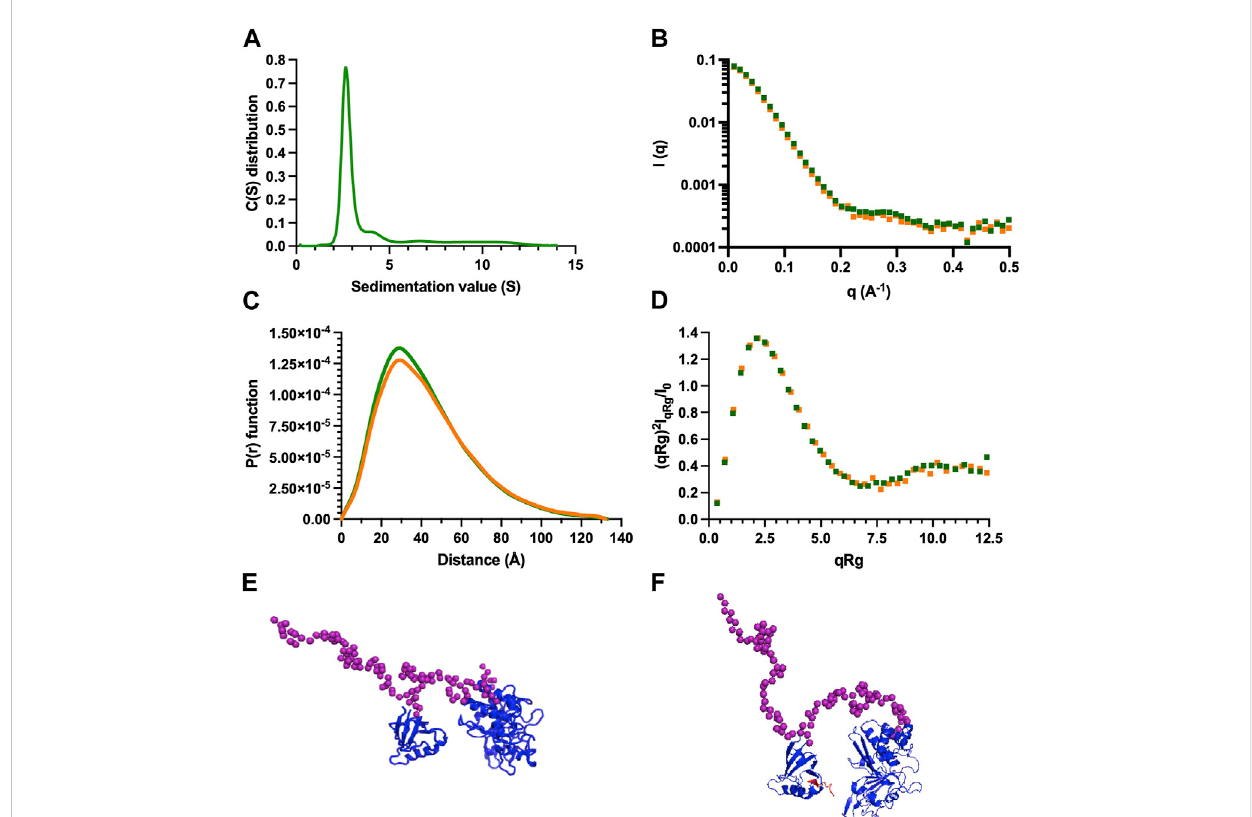
FIGURE 8 AUC and SAXS analysis of PTPN3 Bidomain. Data of PTPN3 Bidomain WT free and complexed to PBM-p38 γ peptide are represented in green and orange, respectively. (A) Sedimentation coef fi cient distributions of free PTPN3 Bidomain. (B) Experimental SAXS data [I (q) versus q]. (C) The P (r) function of the SAXS data, where P is the pair distance distribution function and r is the distance vector. (D) Dimensionless Kratky plots. (E) (F) Models of Bidomain obtained from SAXSdata. Models weregenerated usingCORAL based ontheX-ray structures ofthePDZ (PDBcode6T36) andthecatalyticdomain (PDB code 2B49) of PTPN3. The two domains were rigid and the linker, the N-terminal and the C-terminal part of the PTPN3 were set in random conformations.50modelsweregenerated, thebest modelispresented.ThemodelofPTPN3free (E) andincomplexwithPBM-p38 γ (F) weregenerated comparablyincludingthe PBM (in red) within the X-ray structure of thePDZ. Knownstructures are inblue. The interdomain linker, theN- and C-terminal parts of the bidomain are shown as purple